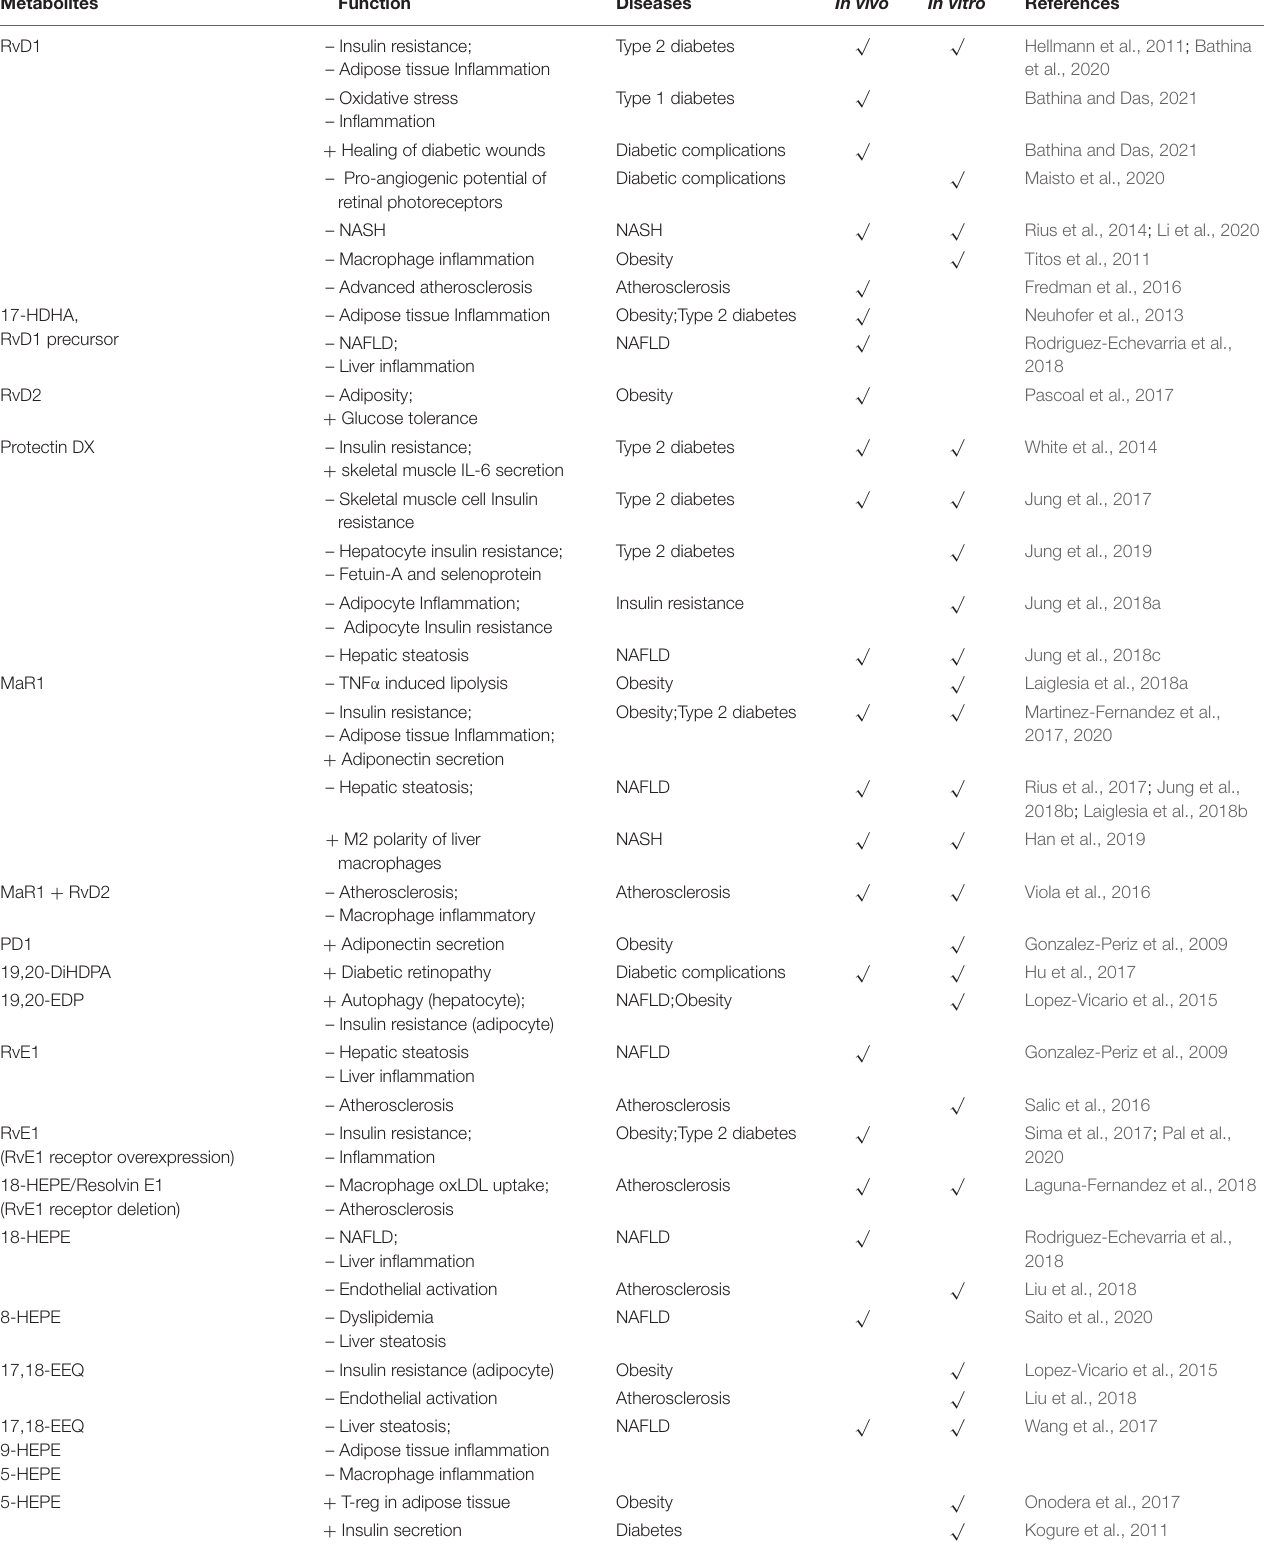
TABLE 2 | The functions of ω -3 PUFA-derived bioactive lipids on metabolic